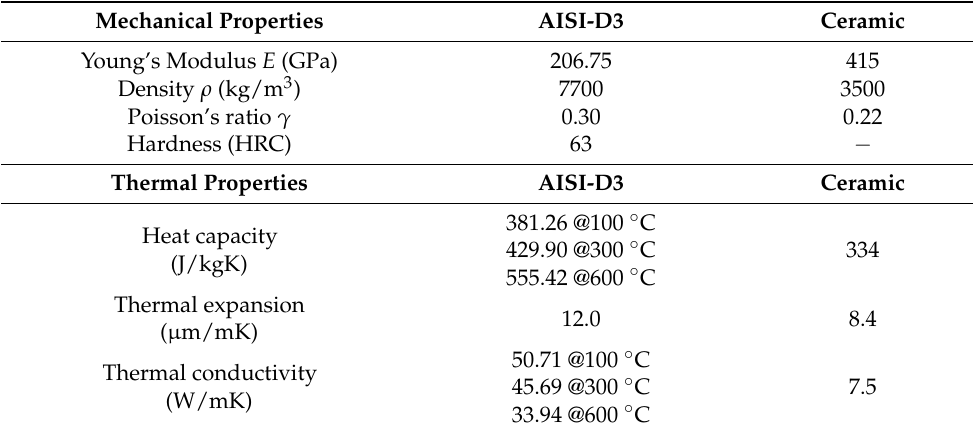
Table 3. Thermo-mechanical properties for the tool [42] and the workpiece